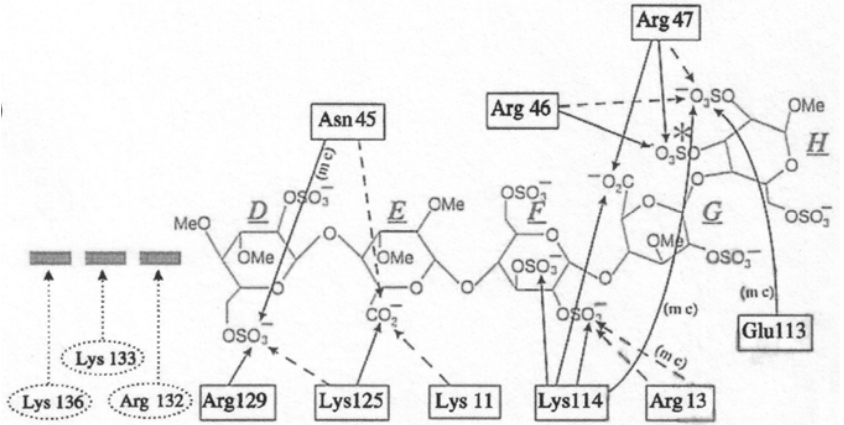
Fig. 2 – Details of protein-glycan contacts in the specific interaction between a heparin-like synthetic pentasaccharide and antithrombin; data from the crystal structure of the complex (Jin et al. 1997) (reproduced with permission). Likely hydrogen bonds are indicated by full lines, and possible bonds in interrupted lines. An extra sulfate is present in this non-natural structure, marked with an asterisk. A longer heparin chain, extended to the nonreducing side of the pentasaccharide shown, could interact with the three residues Arg 132, Lys 135 and Lys